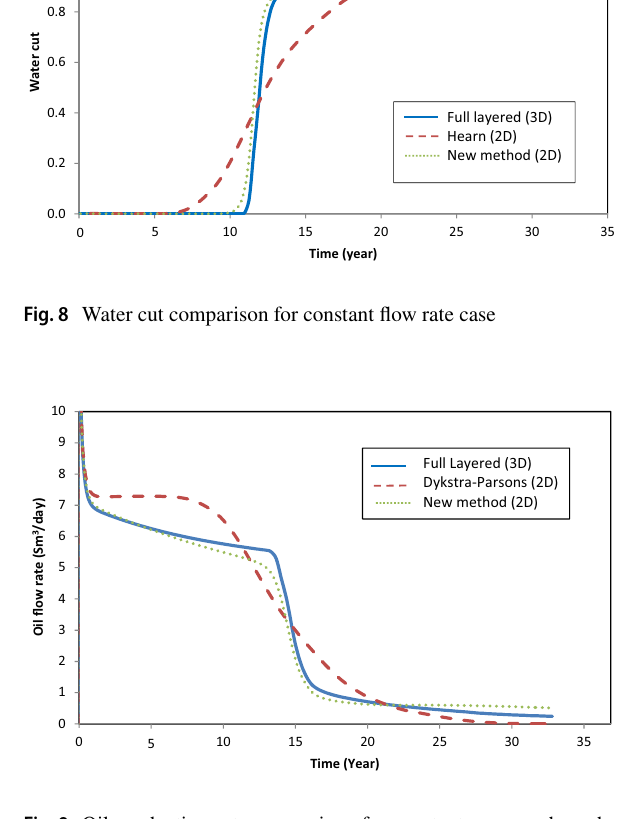
Fig. 9 Oil production rate comparison for constant pressure bounda- ries case